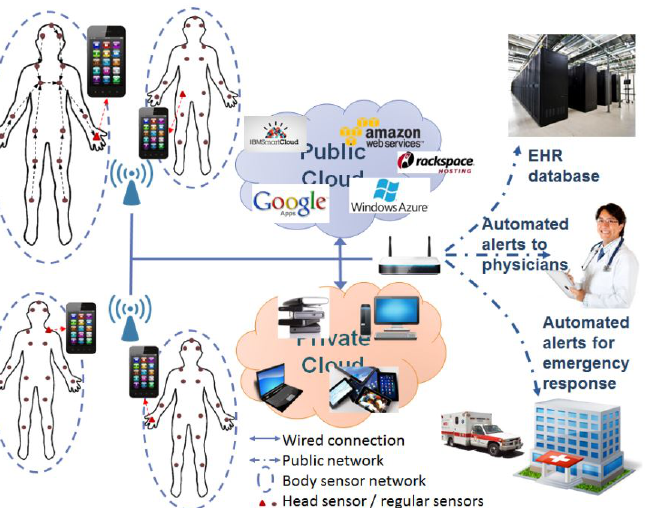
Figure 17. Perspective representation of the MCC technique used in healthcare